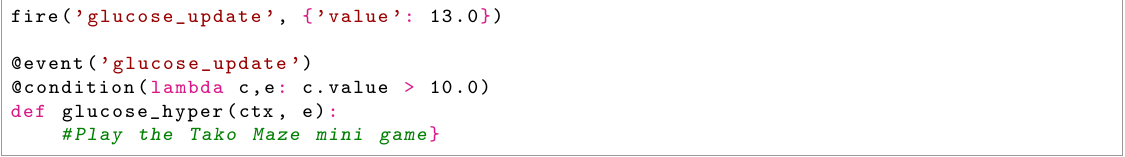
Figure 8. An example of coaching